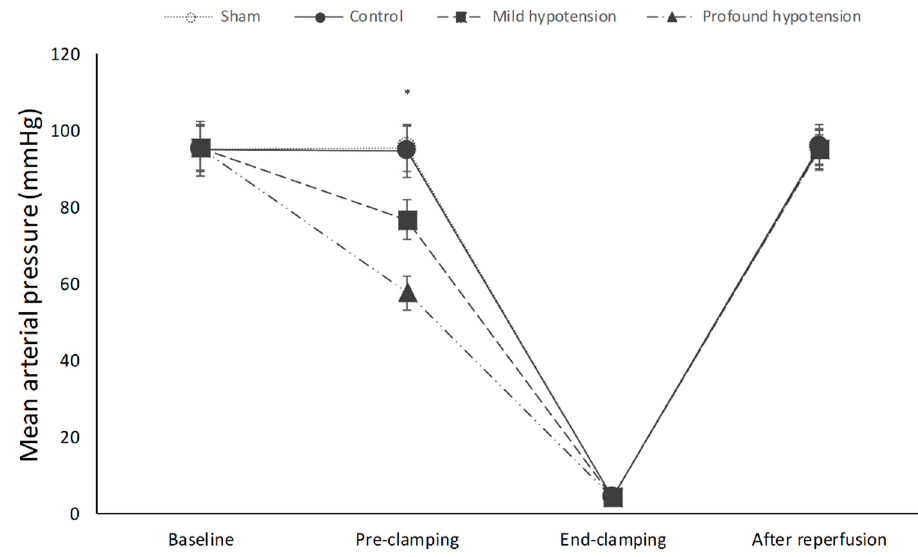
Figure 1. Changes in MAP (mean arterial pressure) during the experiment. There were significant differences in MAP among the 4 groups over time ( p < 0.001). Bonferroni post-hoc comparisons showed that MAP before aortic clamping was significantly lower in the mild (76.5 ± 5.2 mmHg) and profound hypotension group (57.4 ± 4.3 mmHg) than in the control group (94.5 ± 7.0 mmHg) ( p < 0.001). MAP before aortic clamping was also lower in the profound hypotension group compared to the mild hypotension group ( p < 0.001). Results are expressed as mean ± SD.